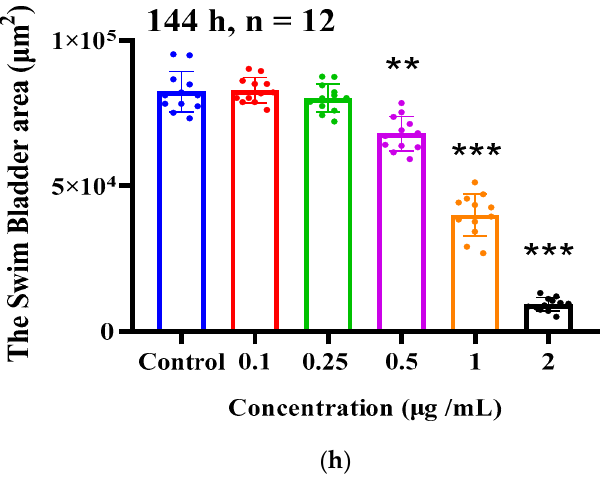
Figure 1. Developmental toxicity of EMB exposure to zebrafish embryos and larvae. ( a ) Survival rate—percentage of surviving fish divided by the total number of fish, n = 3; ( b ) hatching rate, percentage of hatching fish divided by the total number of fish, n = 3; ( c ) representative picture; 24 hpf ( d ) spontaneous movement, n = 12; ( e ) 144 hpf body length, n = 12; ( f ) abnormal spinal curvature rate, percentage of deformed fish divided by the total number of fish, n = 3; ( g ) abnormal yolk sac edema rate, percentage of deformed fish divided by the total number of fish, n = 3; and ( h ) results of fish bladder area statistics, n = 12. * p < 0.05, ** p < 0.01, *** p < 0.001, compared with control groups.